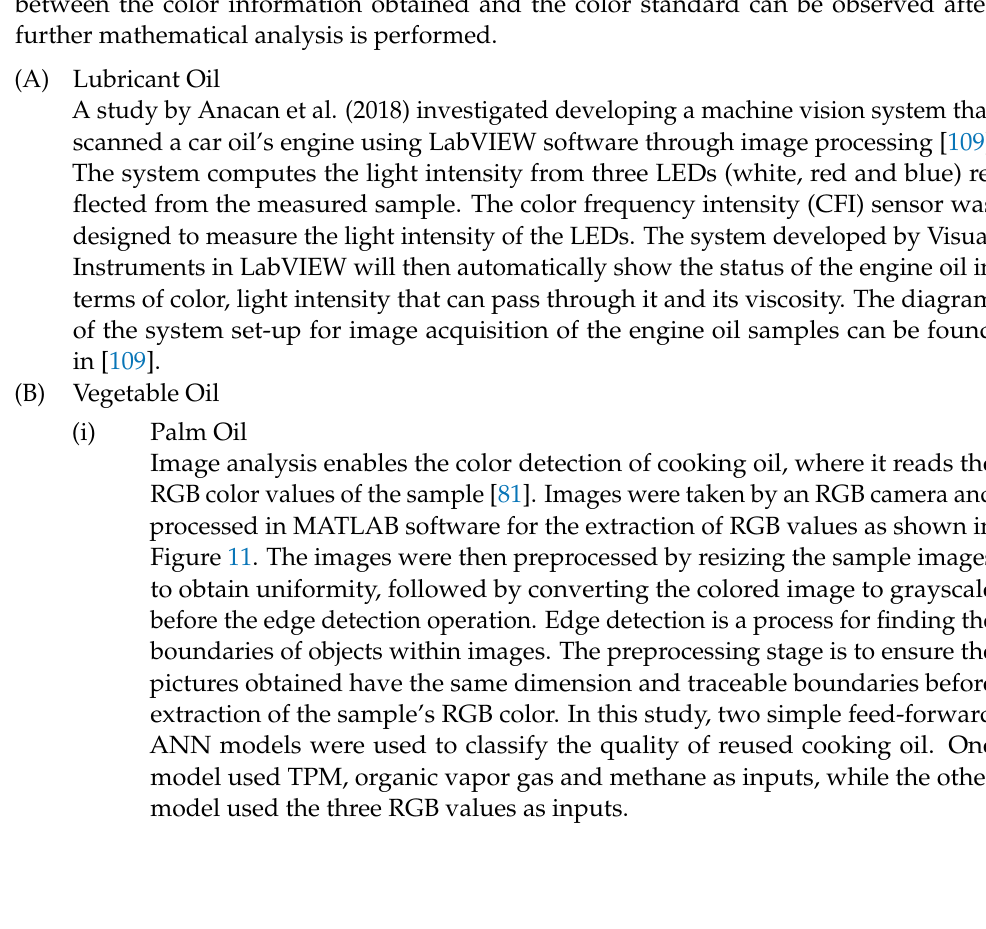
Image analysis enables the color detection of cooking oil, where it reads the RGB color values of the sample [81]. Images were taken by an RGB camera and processed in MATLAB software for the extraction of RGB values as shown in Figure 11. The images were then preprocessed by resizing the sample images to obtain uniformity, followed by converting the colored image to grayscale before the edge detection operation. Edge detection is a process for finding the boundaries of objects within images. The preprocessing stage is to ensure the pictures obtained have the same dimension and traceable boundaries before extraction of the sample’s RGB color. In this study, two simple feed-forward ANN models were used to classify the quality of reused cooking oil. One model used TPM, organic vapor gas and methane as inputs, while the other model used the three RGB values as